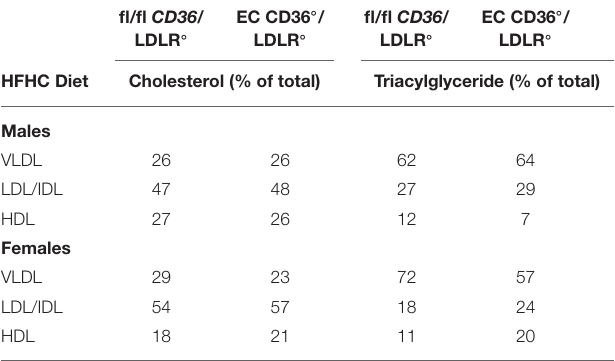
TABLE 2 | Lipoprotein Analysis of Mice Fed With the HFHC Diet. fl/fl CD36 / LDLR